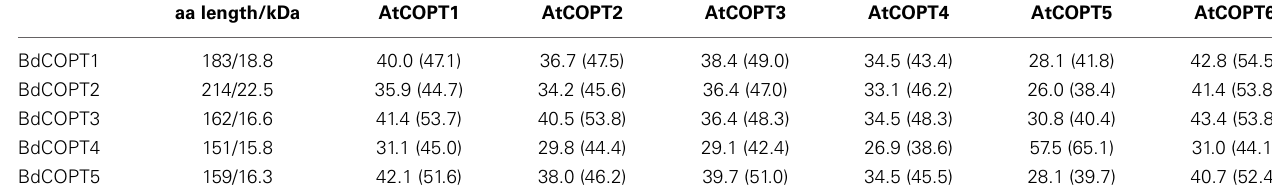
Table 3 | Amino acid length (aa length), molecular mass (shown in kDa), and percentage of amino acid identity (similarity) of putative brachypodium COPT (BdCOPT1-5) transporters in comparison to their homologs in A. thaliana (AtCOPT1-6).